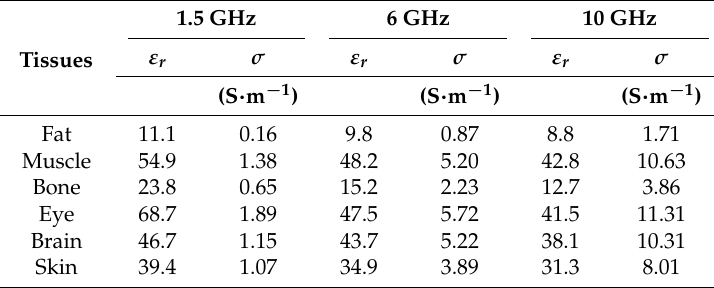
Table 1. Dielectric properties of the rat